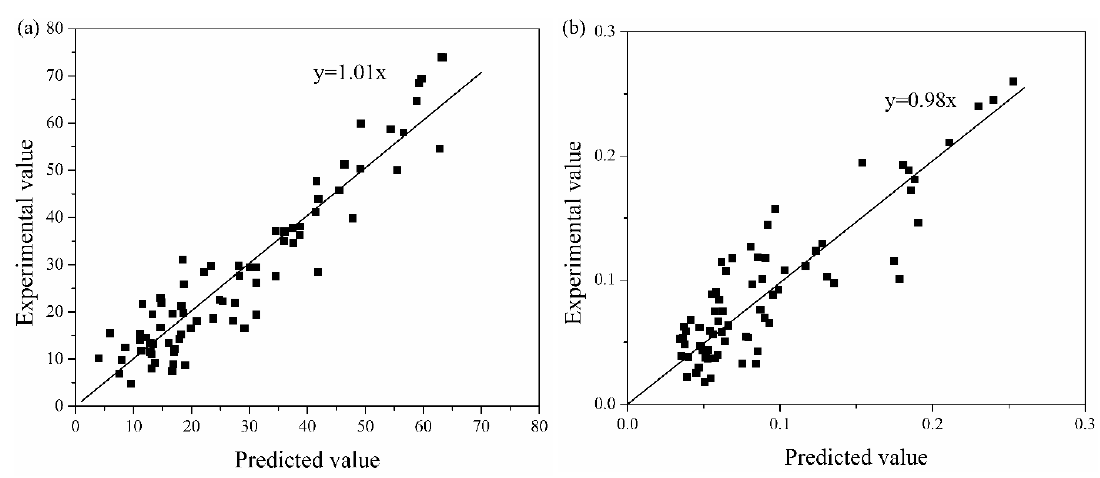
Figure 6. Parity plot of responses; ( a ) %absorption efficiency (%), ( b ) liquid-side volumetric mass transfer coefficient (s − 1 ).